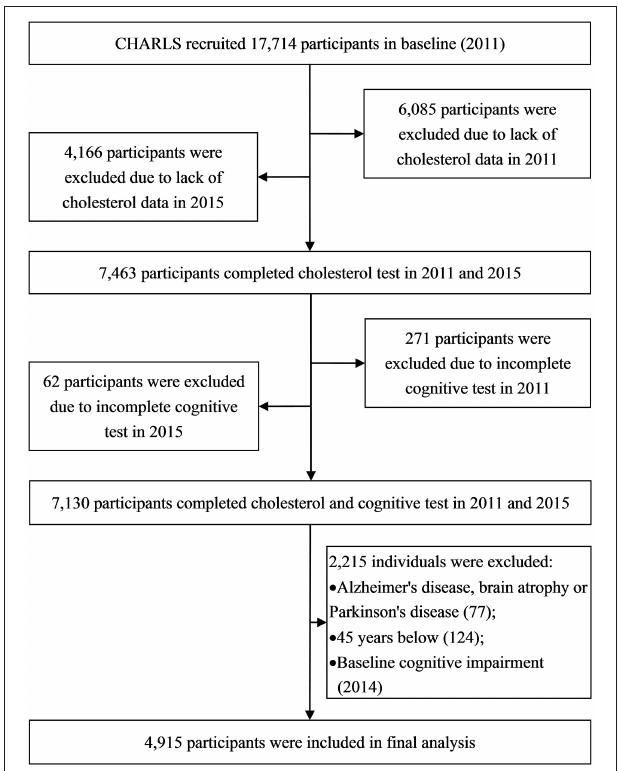
FIGURE 1 | Flowchart of participant